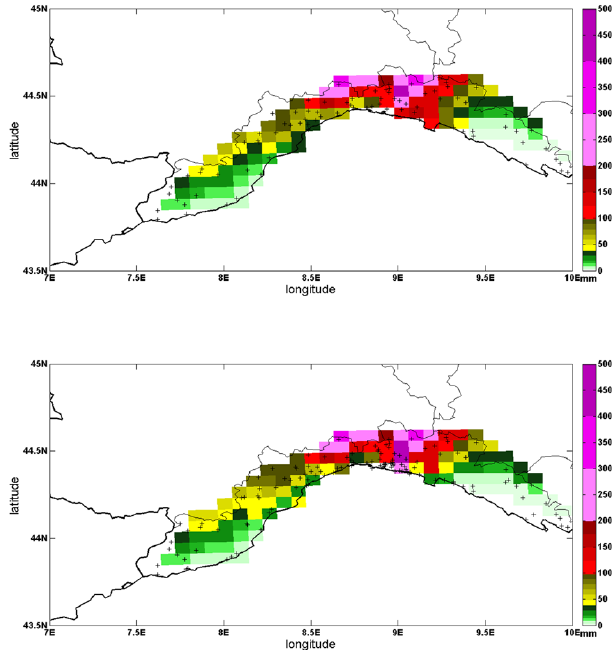
Fig. 8. Daily precipitation maps, (mm), 4 November 2011 over Liguria region, total depth 24h registered by: official ICPD net- work (upper panel), in total 84 rain gauges stations; official ICPD network and PWS (Weather Underground and LIMET) networks (lower panel), in total 132